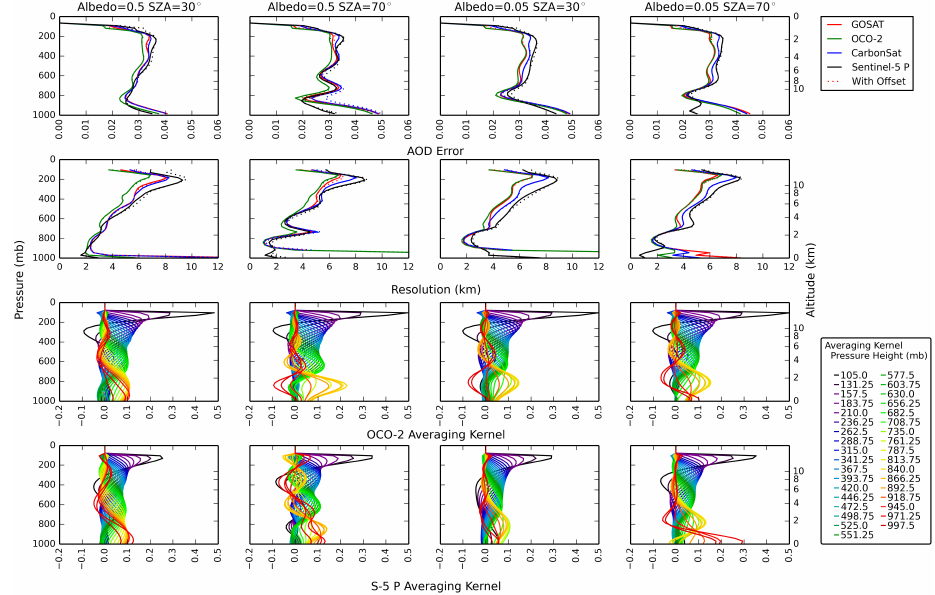
Figure 4. Error of LAOD (top panel) and vertical resolution (middle panel) as a function of pressure for the aerosol profile retrieval for scenario A for surface albedos of 0.05 and 0.5 and SZAs of 30 and 70 ◦ for the four instruments without an intensity offset. The results for a retrieval with intensity offset is shown by the dotted lines. The bottom two rows of panels show the averaging kernels for OCO-2 and S-5 P for the profile retrieval with intensity offset. Note that the top four pressure levels are not